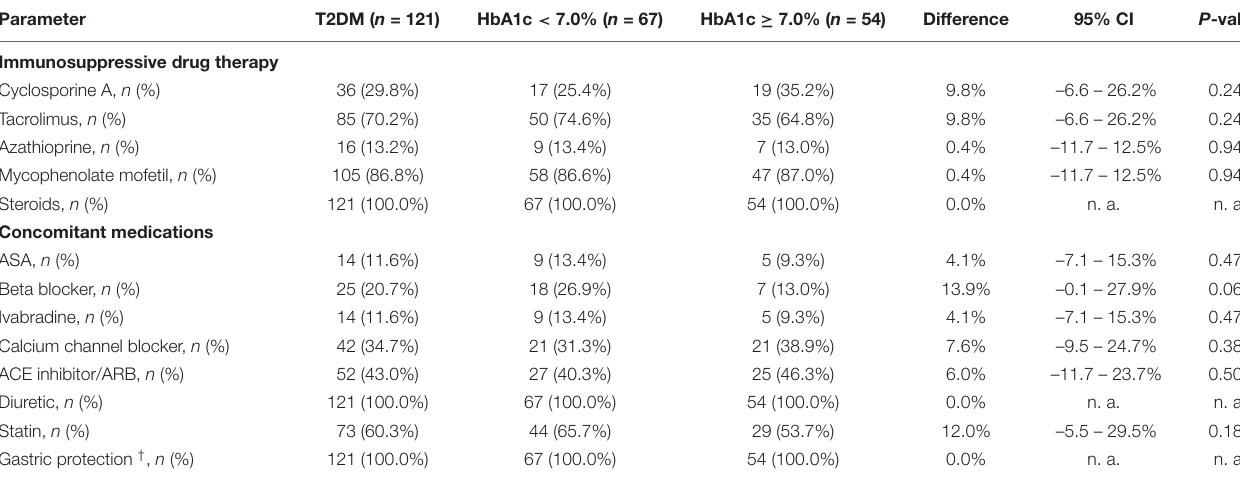
TABLE 4 | Medications after HTX – stratified by HbA1c at